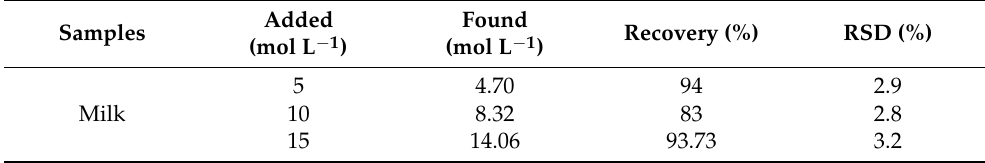
Table 3. Determination of sulfadiazine in spiked real milk samples (RSD n =